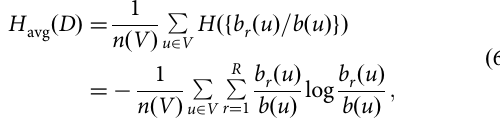
Fig. 2 Ethnoracial distributions in census tracts within the New Haven- Milford, Connecticut metropolitan area. Census tracts are delineated with thin black borders and inferred cluster boundaries from the minimum description length regionalization algorithm are shown with thick black borders for each decade a 1980, b 1990, c 2000, d 2010. Colored points are distributed at random within each tract and each color covers an area proportional to the fraction of the population within the tract that falls under the corresponding ethnoracial category. The inverse compression ratio η (Eq. (18)) and the optimal number of clusters K are shown for each